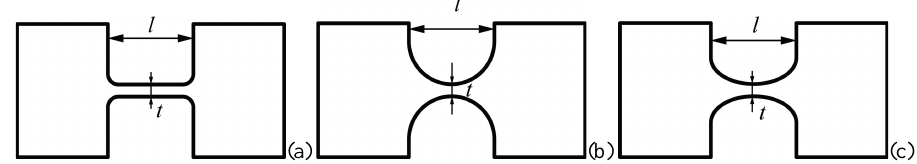
Figure 1. Corner-filleted flexure hinge (a) , circular flexure hinge (b) and elliptical flexure hinge (c)